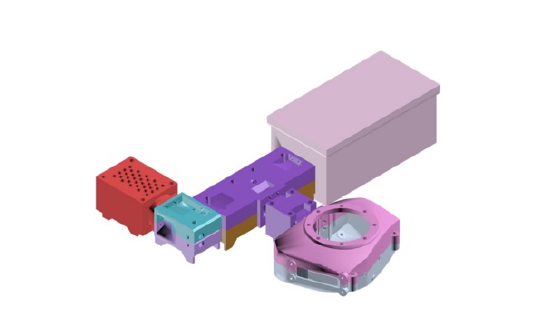
Fig. 5: Raman system with covers